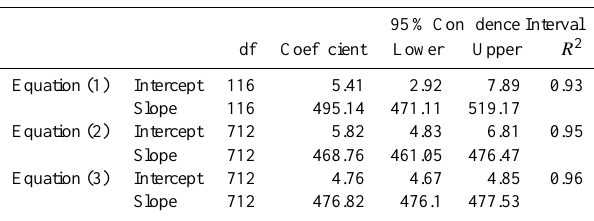
Table 2. Parameters of the linear relationship C d = B d × a + b between dry bulk density B d (gcm − 3 ) and carbon density C d (kgm − 3 ) derived from literature values (Eq. 1) and including field data from this study (Eq. 2) . Eq. (3) was calculated from log trans- formed data to correct heteroscedasticity. Equations valid for C con- centration >